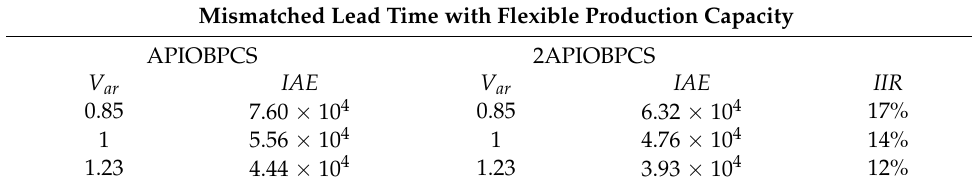
Table 4. Performances of Case 3 for the two models.